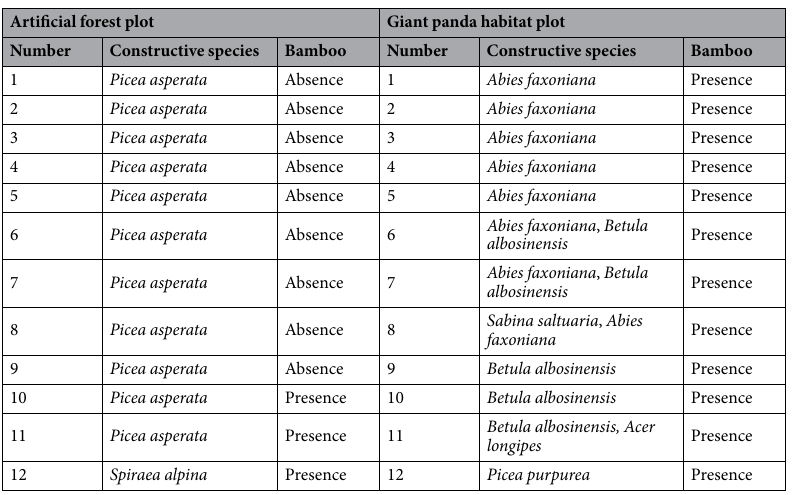
Table 4. Community collocation model of artificial forest plot and giant panda habitat